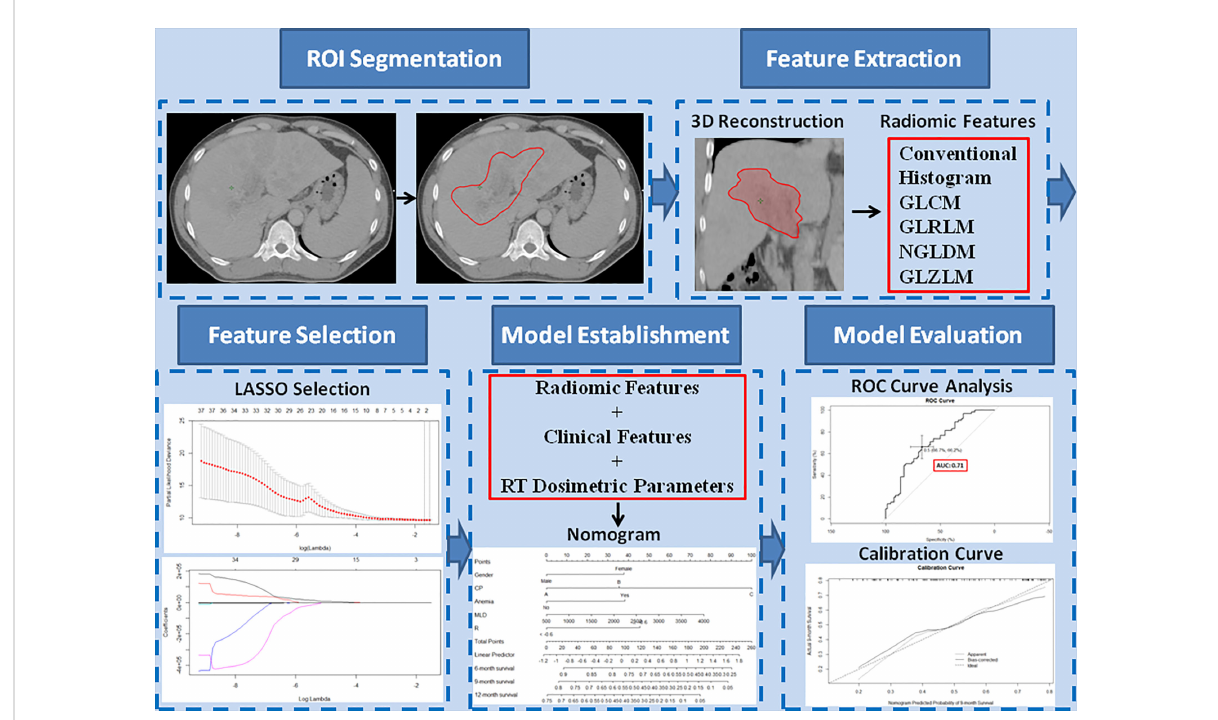
FIGURE 1 Study work fl ow. The region of interest (ROI) was segmented on all transverse contrast-enhanced computed tomography images by experienced radiation oncologists using the Eclipse system. After a three-dimensional reconstruction of the ROI, 48 textural features, including conventional features, histogram features, gray-level co-occurrence matrix, gray-level run-length matrix, neighborhood gray-level dependence matrix, and gray-level zone length matrix, were extracted. The extracted features were selected by least absolute shrinkage and selection operator regression. Based on the selected radiomics features, clinical features, and radiation therapy dosimetric parameters, a nomogram model was established to predict overall survival. The performance of the predictive model was evaluated with concordance index, area under the curve of the receiver operating characteristic curve, and calibration